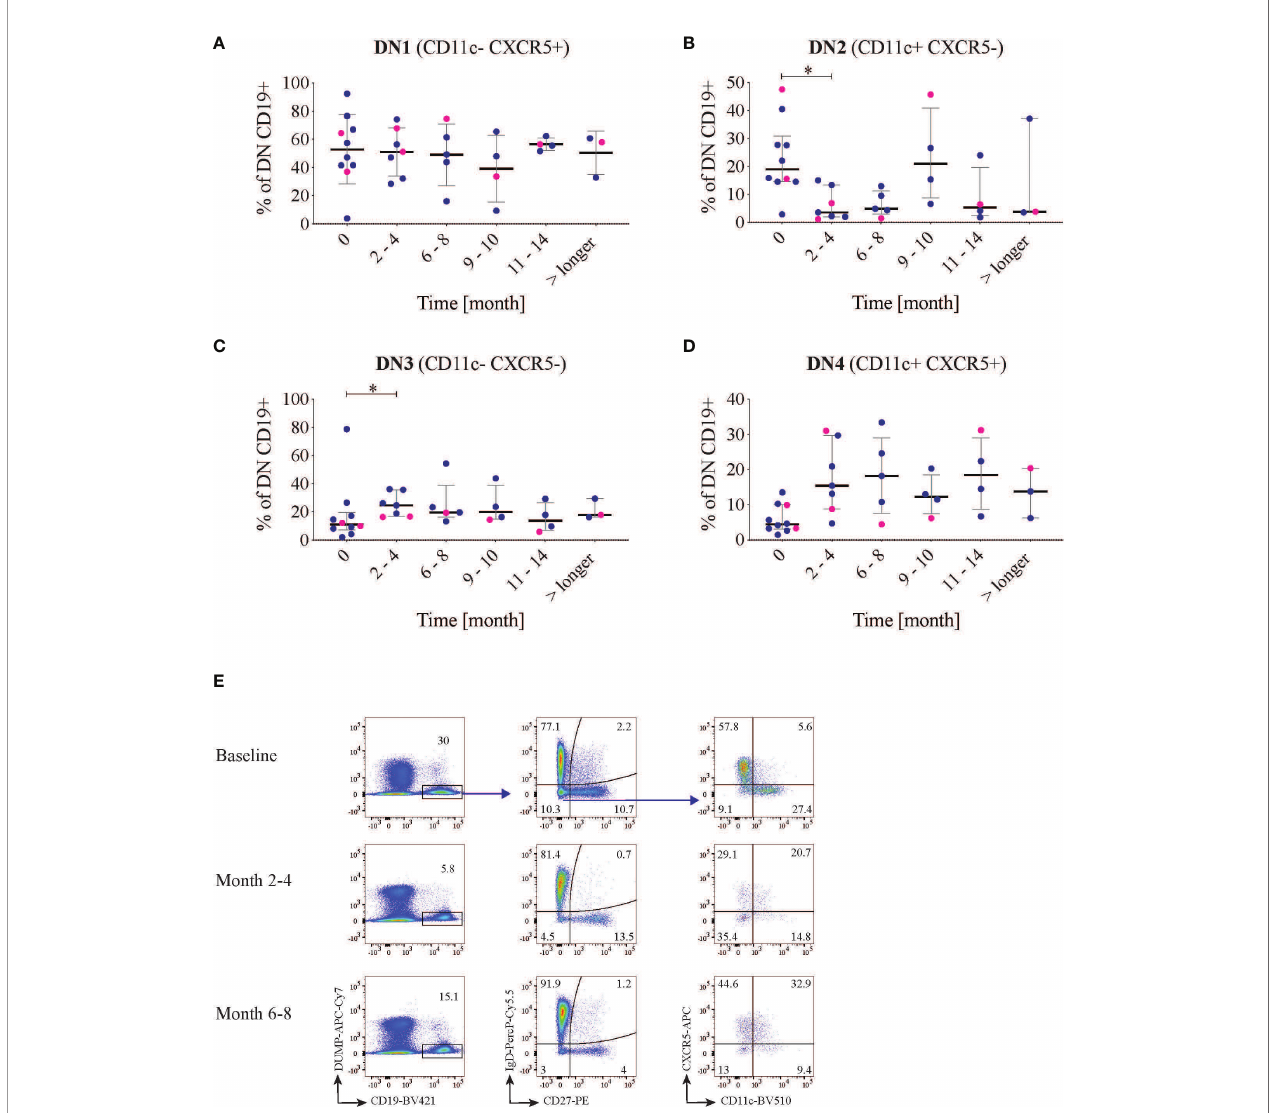
FIGURE 3 | Double negative (DN) B subsets changes. CD19 B cells were fi rst gated for IgD- CD27- cells and then divided into four different groups using the markers CXCR5 and CD11c (n=10). The graphs show the frequency of DN1 (A) (CXCR5+ CD11c-), DN2 (B) (CXCR5-CD11c+), DN3 (C) (CXCR5- CD11c-) and DN4 (D) (CXCR5+ CD11c+) B cells after rituximab treatment over time. LN patients are indicated in blue and non-LN patients in pink. (E) representative dot plot of the gating strategy in one patient at different time points.